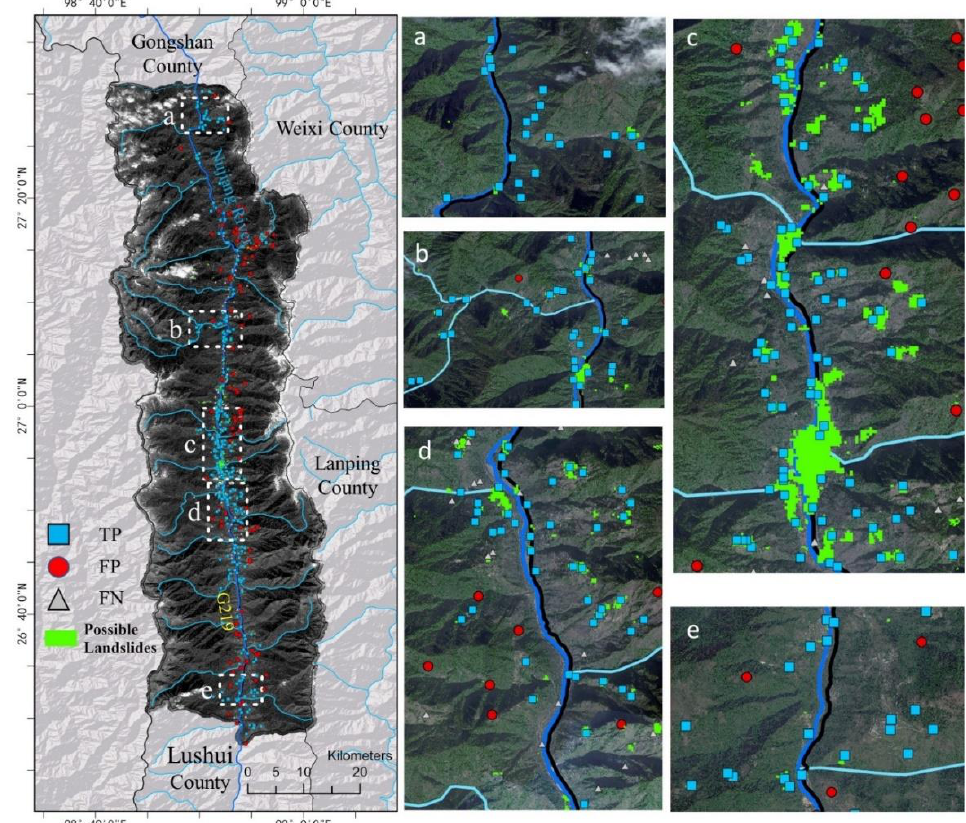
Figure 10. The results of the combination of SBAS-InSAR and Yolo. Here, TP is the intersection of the combination results and the references; FP indicates those not recorded in the reference inventory; and FN indicates references not identified by the combination. Scatter points having deformation rate > 10 mm/y are considered possible landslides. Panel ( a – e ) are used to display specific regions of the left panel more clearly.